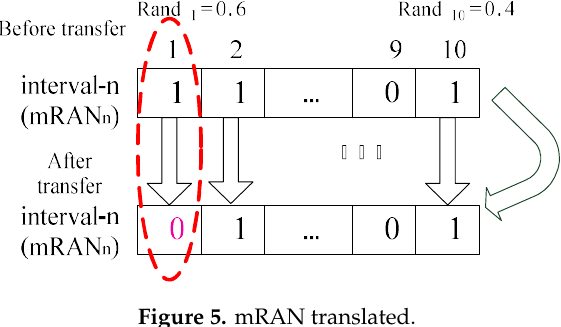
Figure 5. mRAN translated.